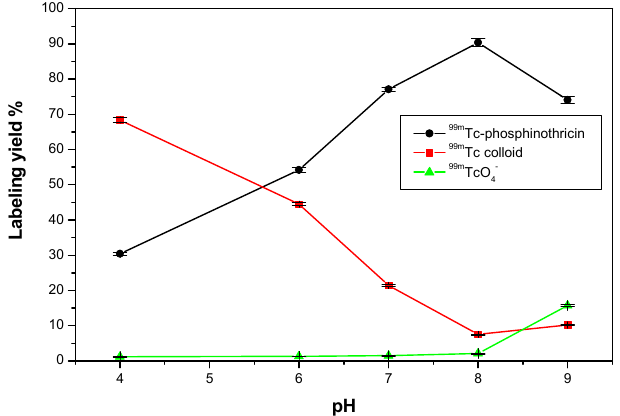
Figure 10 . Radiochemical yield of 99m Tc-phosphinothricin as a function of reaction pH. Reaction conditions: 1.5 mg of phosphinothricin, 10 µg SnCl 2 ·2H 2 O, and 100 µL (7.2 MBq) of 99m TcO 4 − solution, for 15 min.